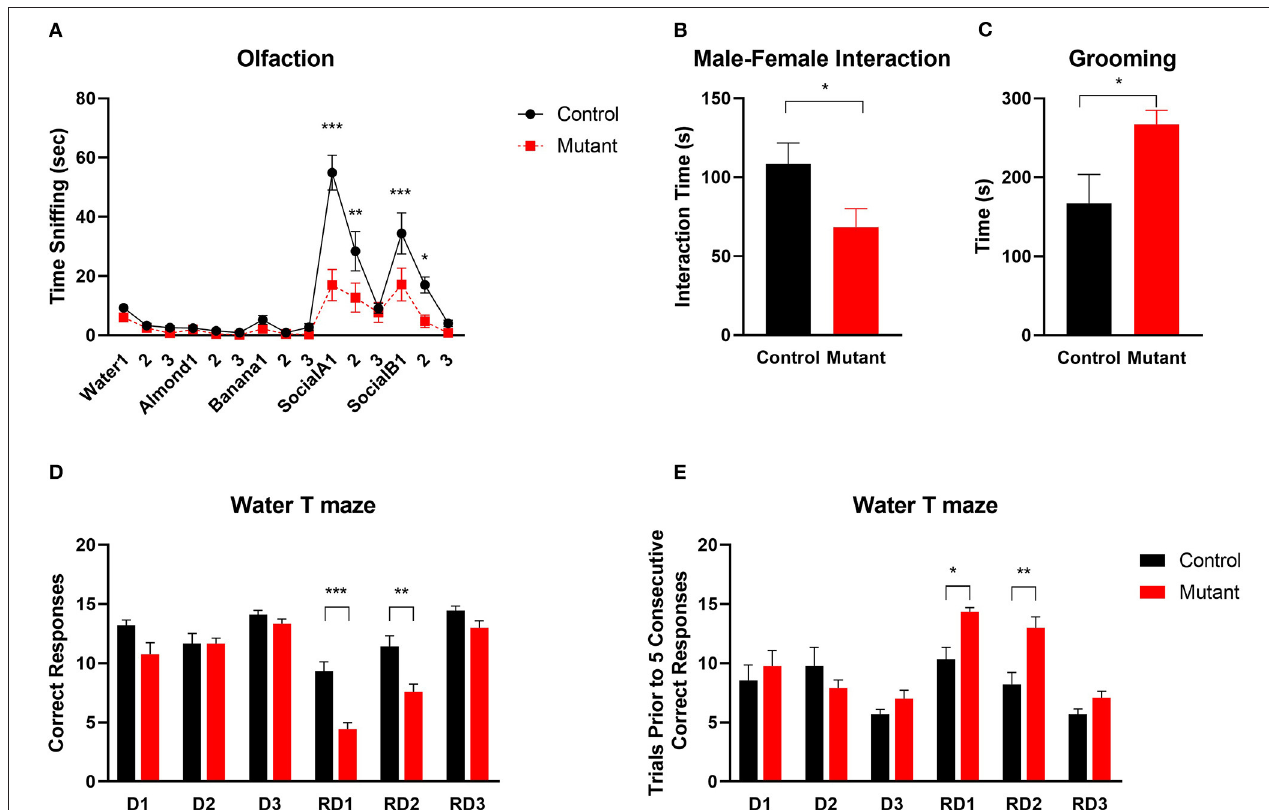
FIGURE 6 | Abnormal social and repetitive behaviors and impaired reversal learning in PC Scn8a mutant mice. (A) Mutant mice spent comparable time sniffing non-social stimuli whereas less time sniffing social odor cues ( n = 11 per group). (B) Reduced sociability of KO mice is indicated by reduced time interacting with a female conspecific (Control: n = 8; Mutant: n = 10). (C) PC Scn8a mutant mice spent more time self-grooming (Control: n = 10; Mutant: n = 11). (D,E) On Day 1 to Day 3, mutants display normal acquisition learning of the escape platform location in the water T maze as indicated by total correct trials (D) and trials needed for 5 consecutive correct responses (E) . However, on reversal day 1 and day 2, PC Scn8a mutant mice have significantly fewer correct trials (D) , and take more trials to achieve five consecutive correct responses (Control: n = 9, Mutant: n = 12). RD, Reversal Day. Data shown are means ± SEM. * P < 0.05, ** P < 0.01, *** P <